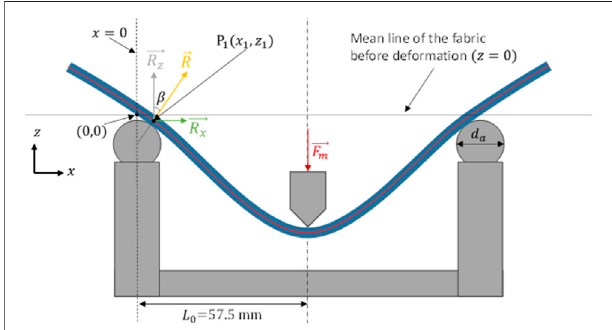
FIGURE 6 | Point of contact between support and fabric; and direction of support